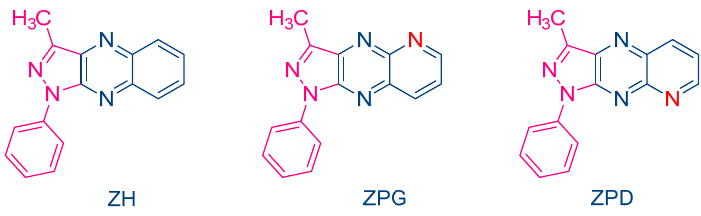
Figure 4. Chemical structures of ZH, ZPG and ZPD.